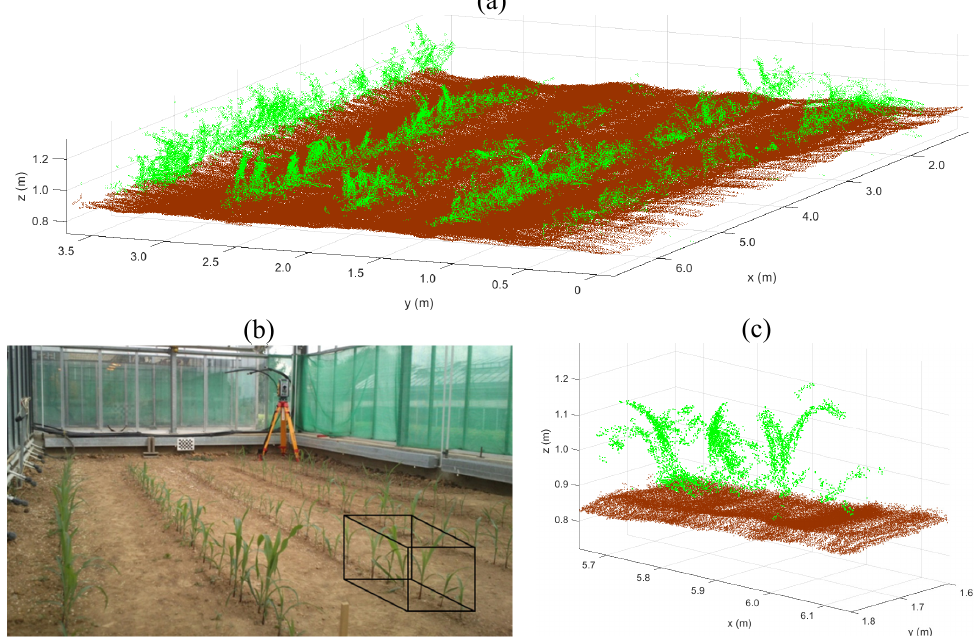
Figure 11. ( a ) 3D view of the 21 m 2 (3.75 m wide and 5.6 m length) of the maize field, with 1,630,832 and 55,083 ground and plant impacts, respectively; ( b ) Picture of the maize field; ( c ) Plants zoom of the area within the black cube represented in